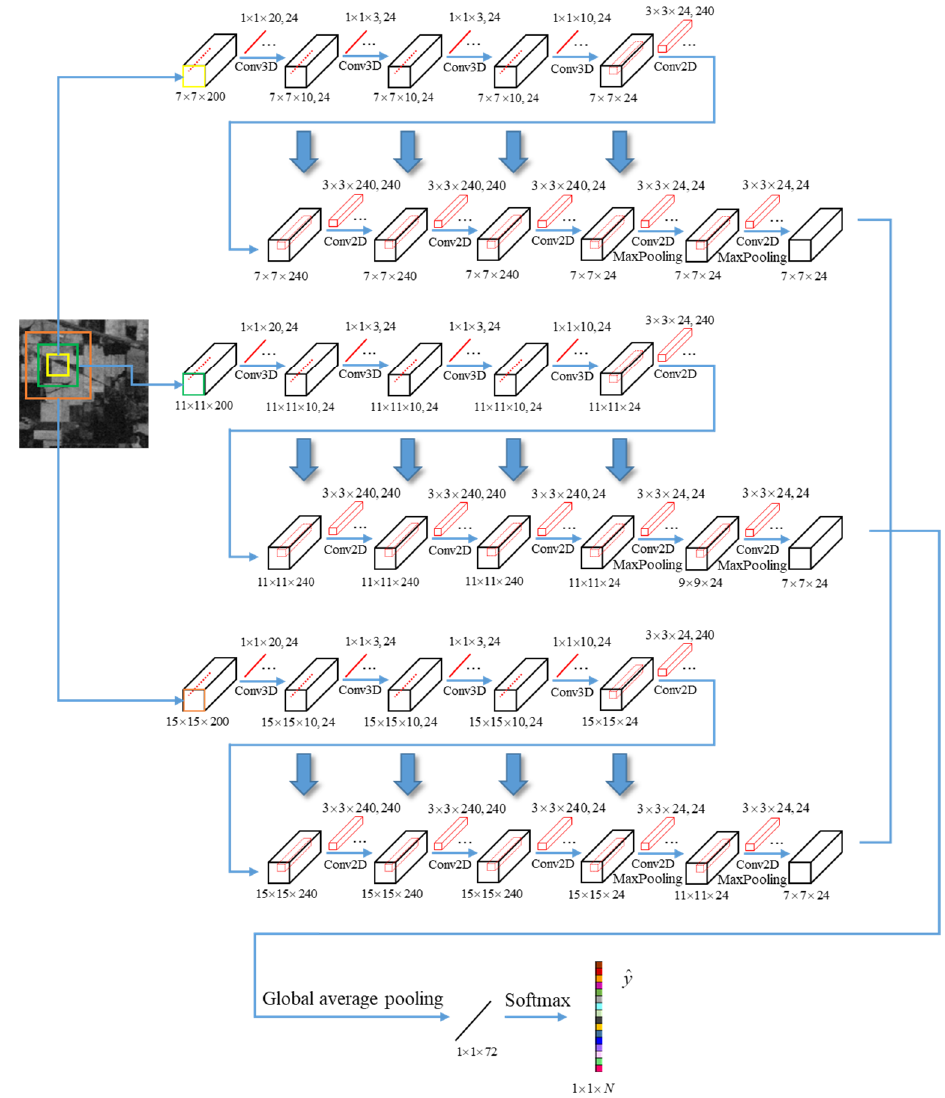
Figure 3. MSSN with 7 × 7 × 200, 11 × 11 × 200, and 15 × 15 × 200 hyperspectral neighborhood blocks as input; each scale branch of the network contains a 3D–2D alternating residual block and a transition layer. The global average pooling layer and softmax layer transform 7 × 7 × 72 fusion features into a 1 × 1 × N output feature vector ˆ y